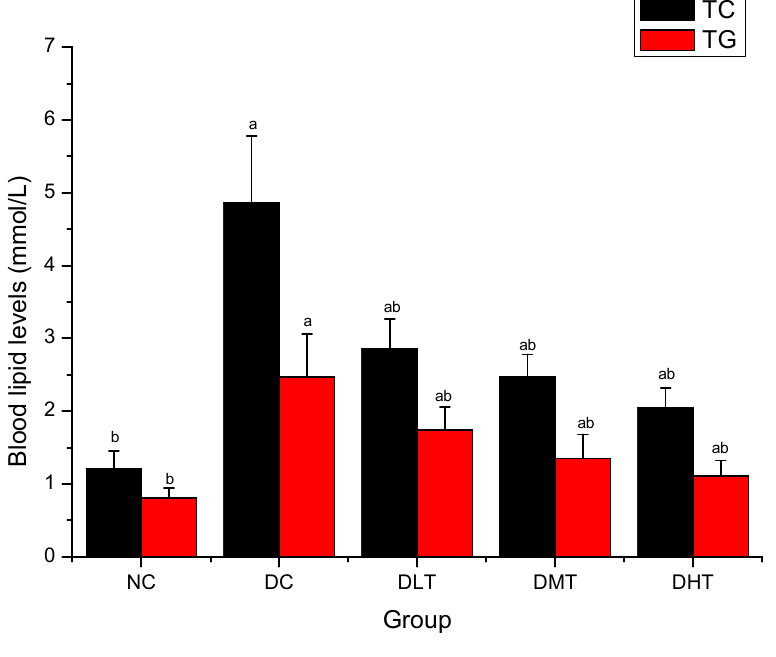
Figure 4. Effect of salidroside administration on blood lipid levels in mice. Data were presented as means ± SD. NC: normal control, DC: diabetic control; DLT: low dose salidroside (50 mg/kg) treatment, DMT: middle dose salidroside (100 mg/kg) treatment, DHT: high dose salidroside (200 mg/kg) treatment. a P < 0.05 as compared with the NC group. b P < 0.05 as compared with the DC